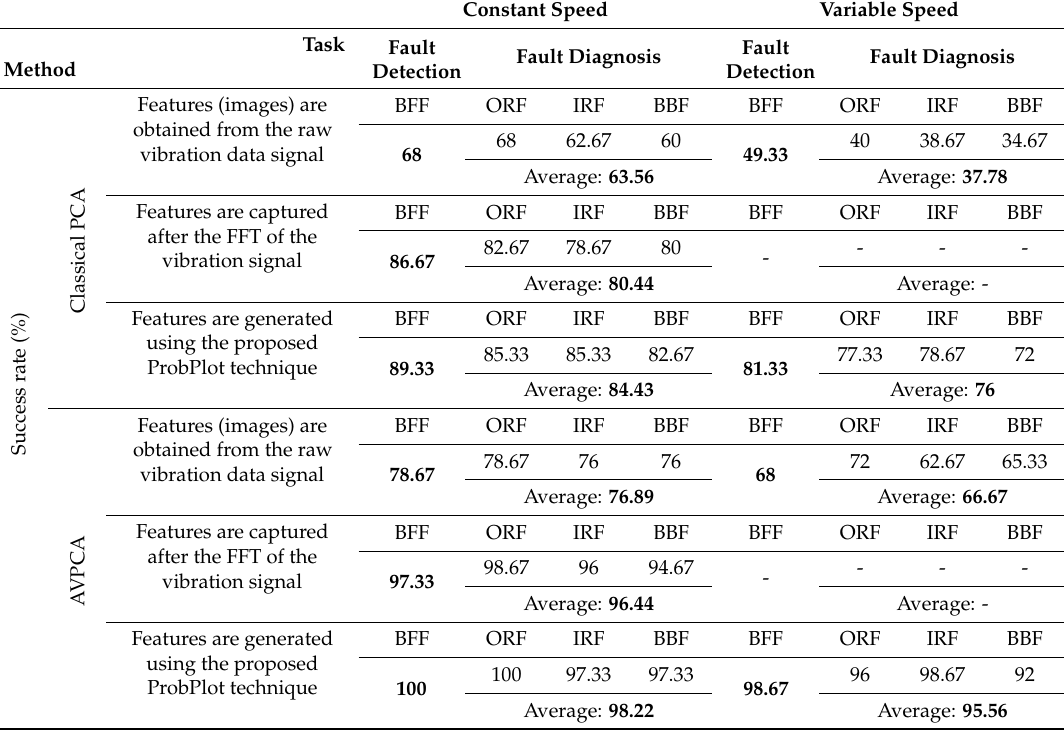
Table 3. Summary of proposed ProbPlot via IR-AVPCA-based BFDD efficiency for the different features (images) generation methods using PCA and AVPCA algorithms under both constant and variable speed